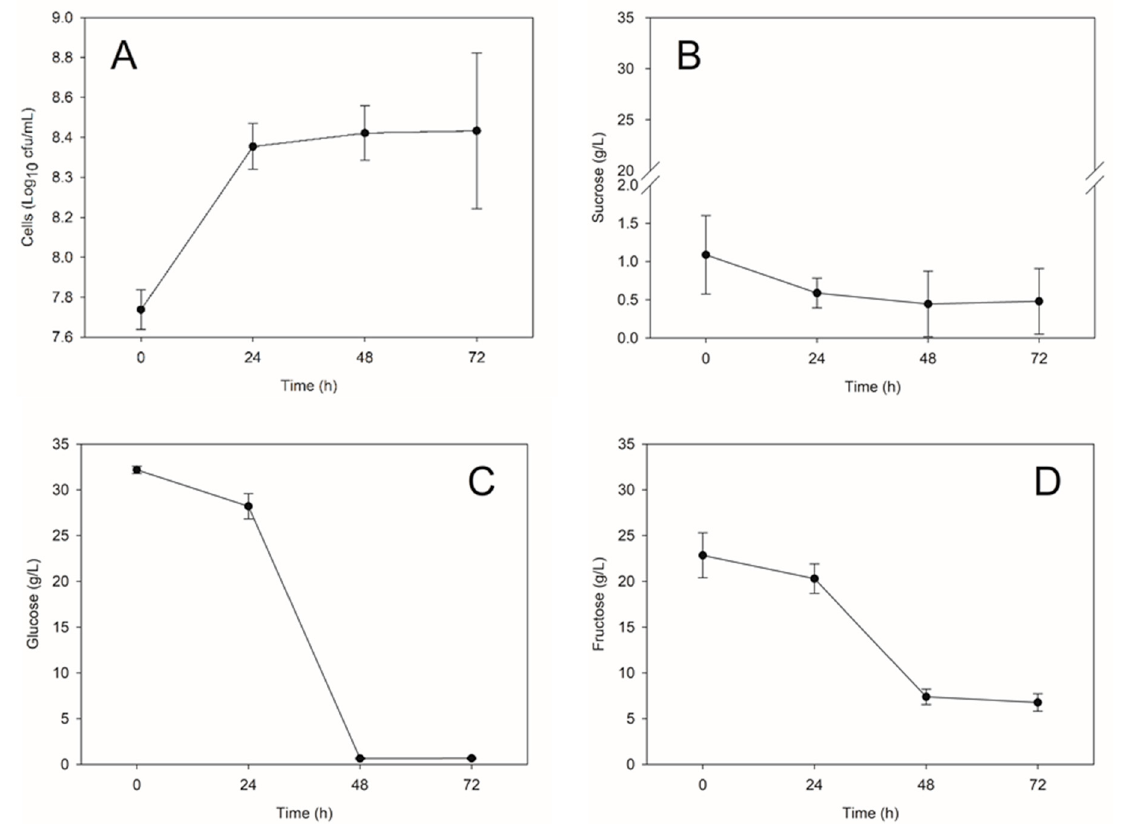
Figure 1. Cell growth ( A ) and the consumption of sucrose ( B ), glucose ( C ), and fructose ( D ) by the probiotic yeast Saccharomyces cerevisiae Sc47 in a medium composed of sugarcane molasses and soybean bran acid hydrolysate.